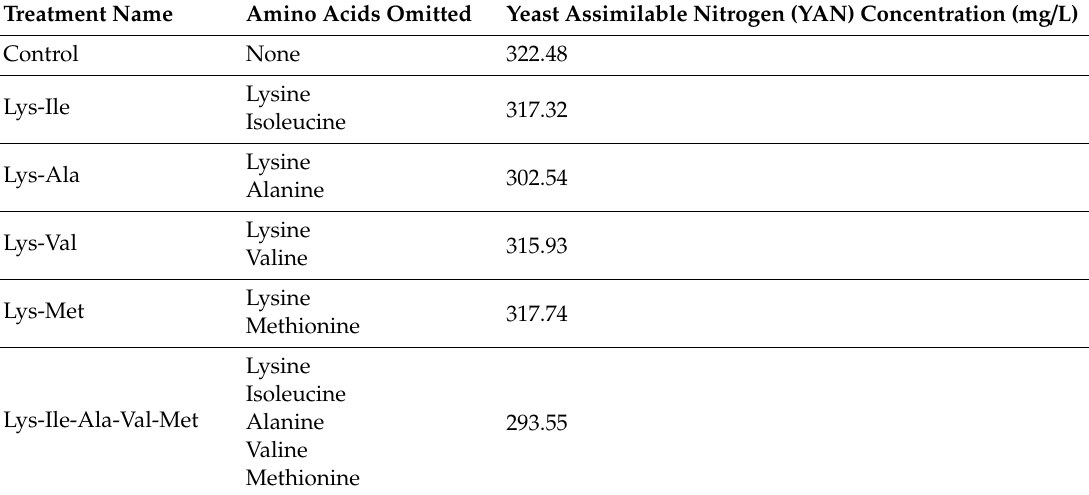
19 listed amino acids (Table 1), with lysine and one of the following amino acids omitted: isoleucine, alanine, valine, or methionine. The remaining treatment contained 14 amino acids, with the following amino acids omitted: lysine, isoleucine, alanine, valine, and methionine (Table 2). The positive and un-inoculated controls contained all 19 amino acids. Fermentations were carried out for 336 h and sampling was performed at 0, 48, 120, 192, 240, and 336 h. Table 2. Amino acid treatments used in this